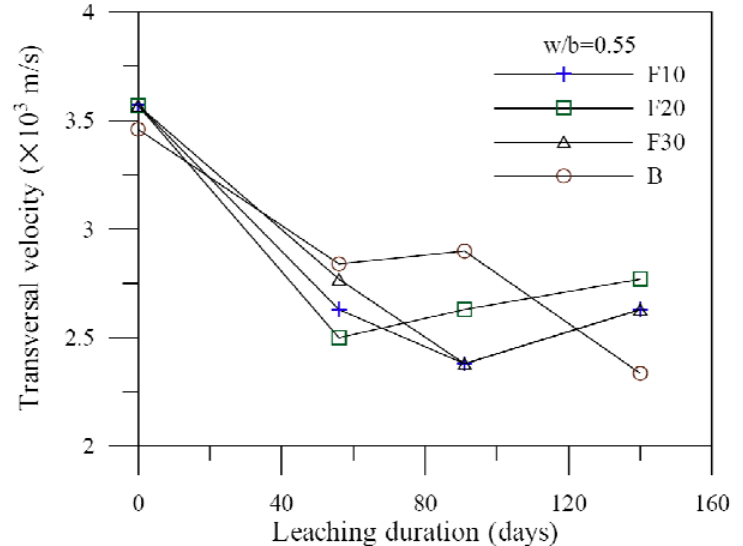
Figure 23. Ultrasonic measurement of the specimen with fly ash admixture